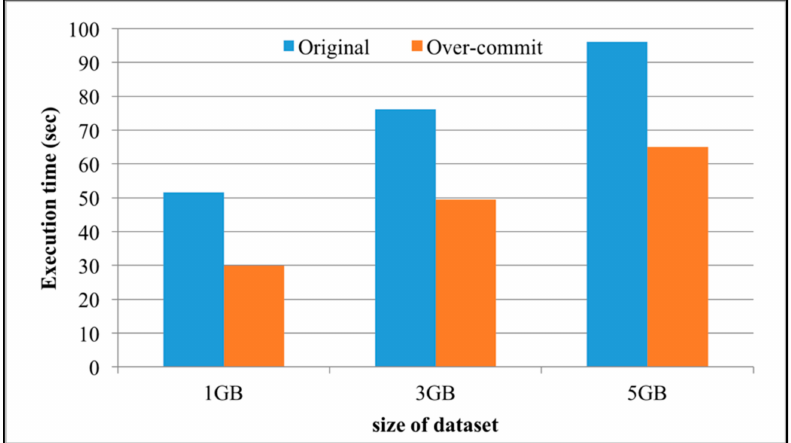
Figure 13. Execution time of executing WordCount without over-committed resources and with 64 over-committed